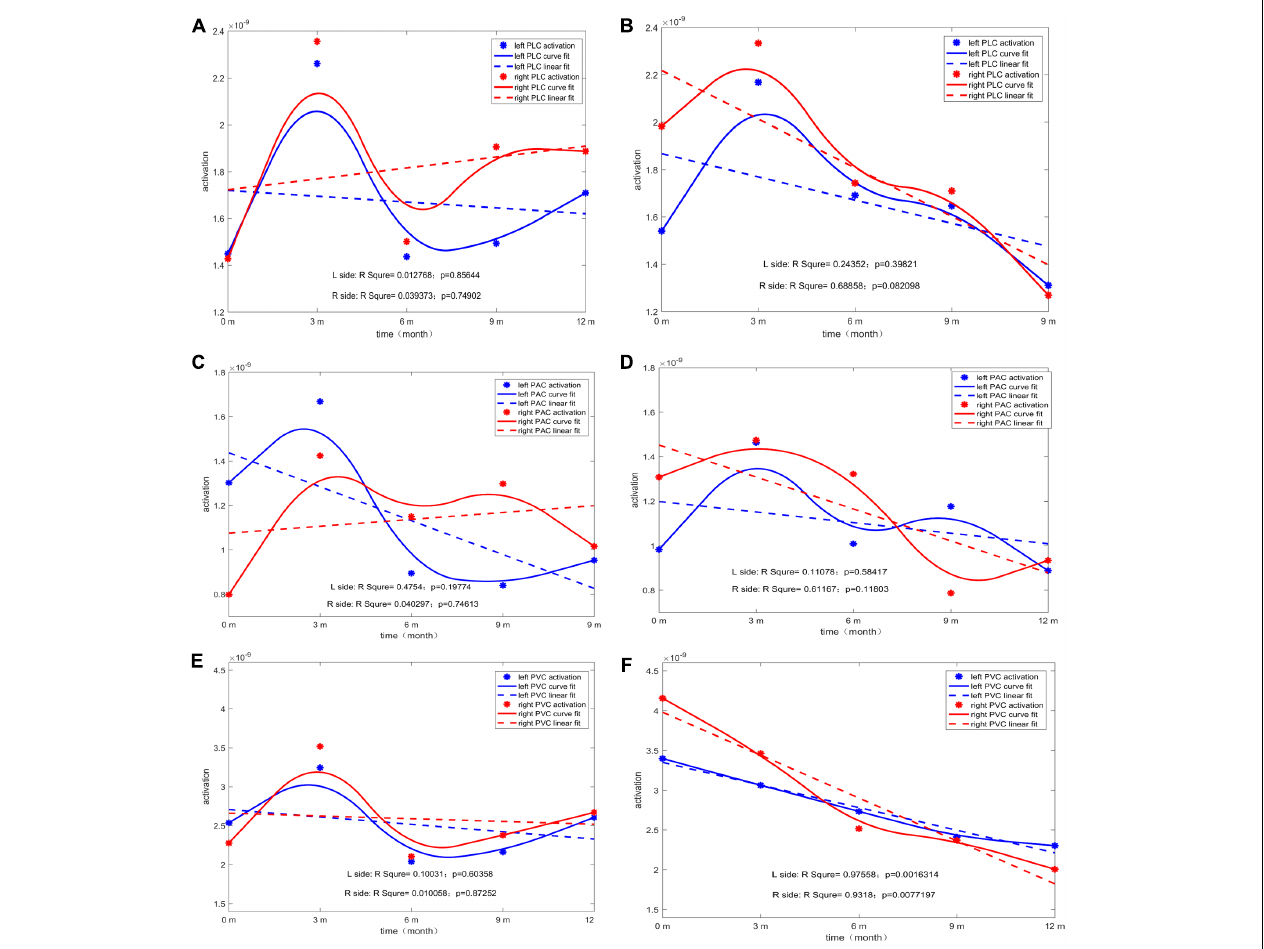
FIGURE 5 | The temporal evolution of average activation of the two ROIs (left and right) as a function of the duration of CI for both GCP and PCP. Evolution of left or right PLC with the increase in CI use for PCP (A) and GCP (B) . Evolution of left or right PAC with the increase in CI use for PCP (C) and GCP (D) . Evolution of left or right PVC with the increase in CI use for PCP (E) and GCP (F)